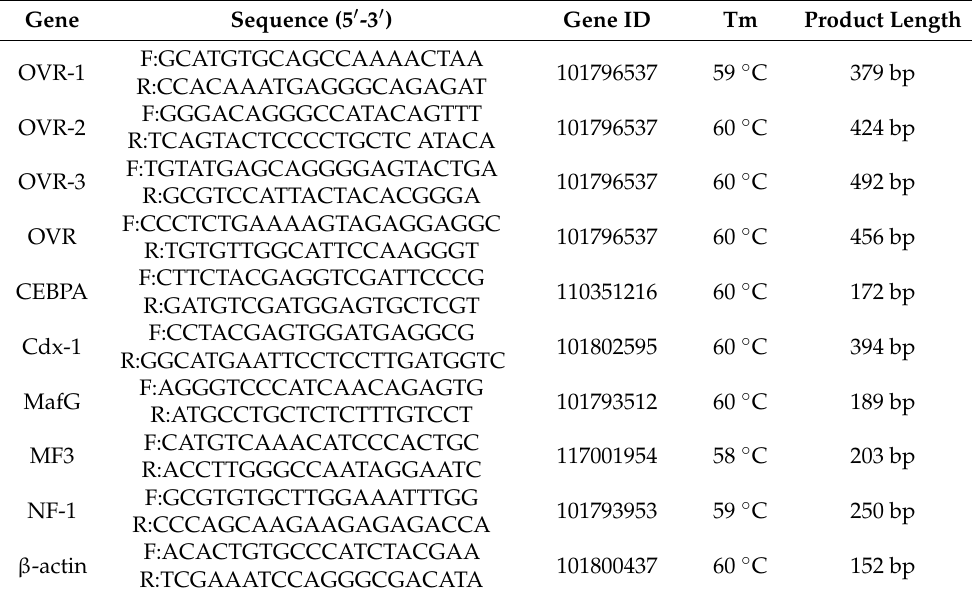
Table 1. Primers information for